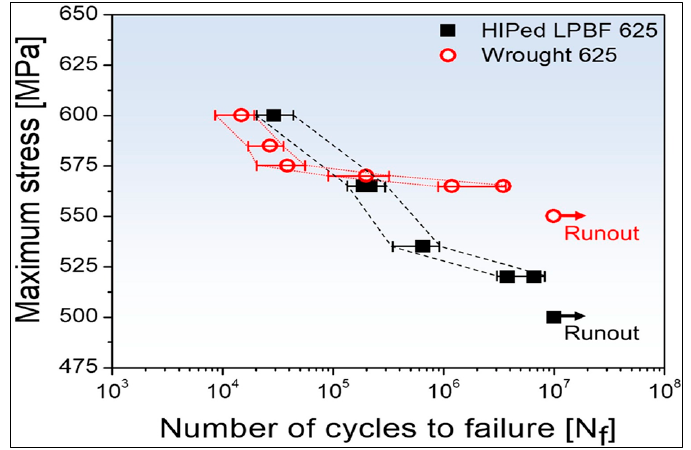
Figure 15. Maximum stress vs. fatigue life of HIPed LPBF 625 and wrought 625 at 650 °C (adapted with permission from Ref. [51] 2020, Elsevier).